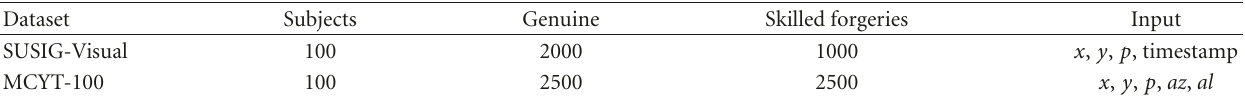
Table 1: The summarizing characteristics of the public databases used in this study. In both of them, the genuine signatures are collected in multiple sessions and there are 5 reference signatures per user.